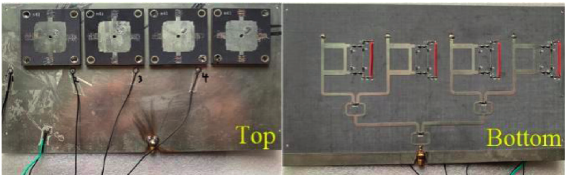
Figure 11: Photograph of the fabricated prototype.